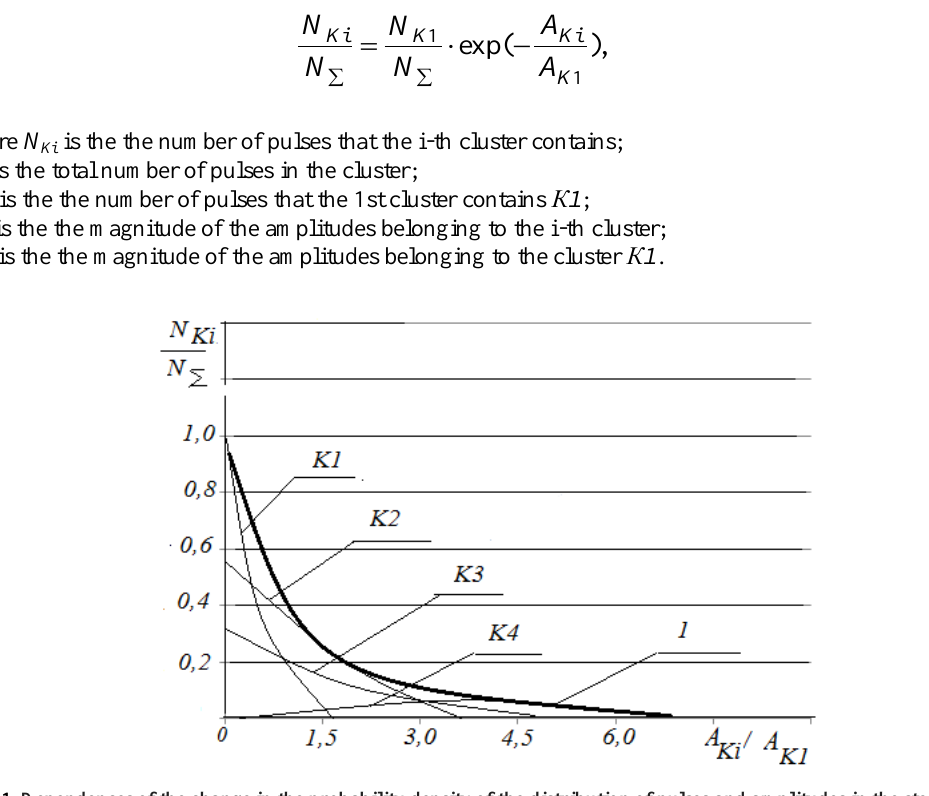
Fig.1. Dependences of the change in the probability density of the distribution of pulses and amplitudes in the steady-state operation of the tribosystem under load N = 1500 N: 1 – envelope